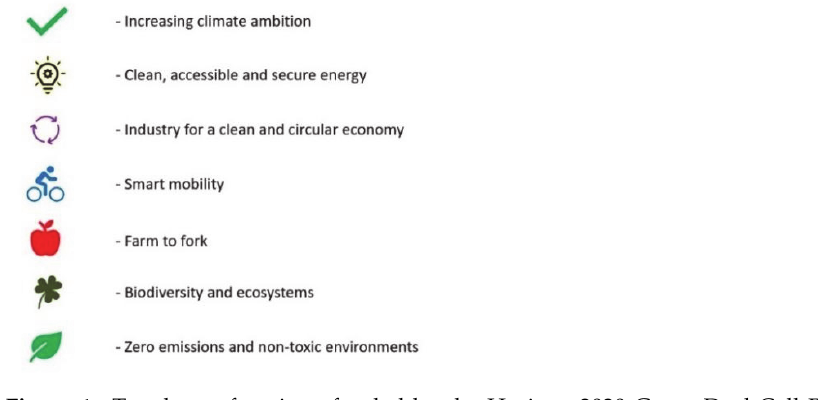
Figure 1. Typology of projects funded by the Horizon 2020 Green Deal Call Program. Source: own